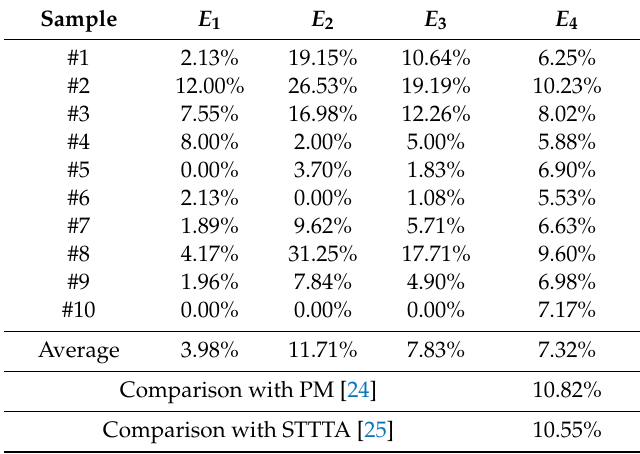
Table 7. Detection error rates of CSM compared with the reference method with 10 samples under variable speed walking.